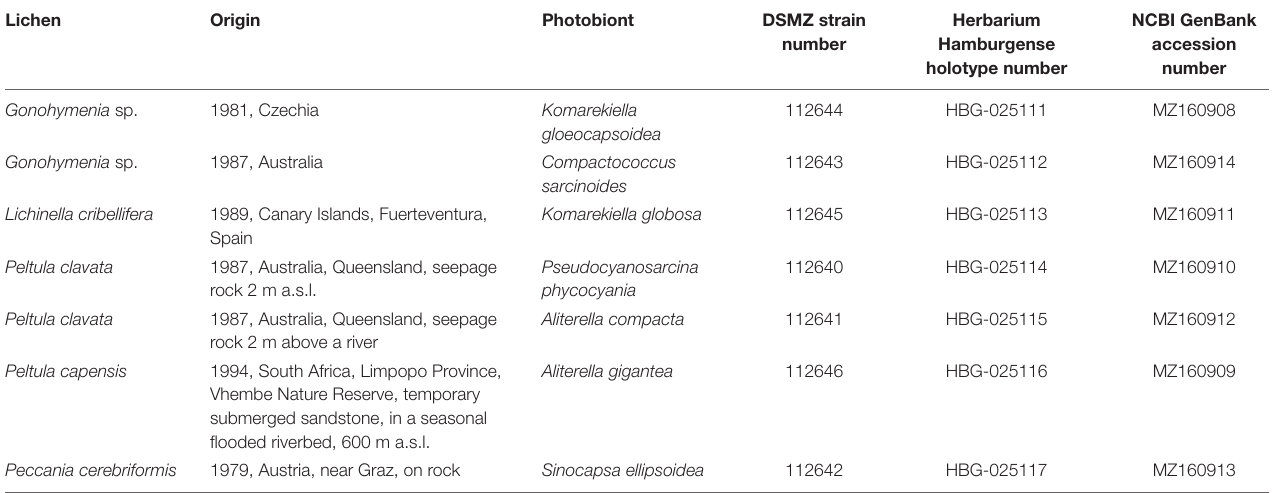
TABLE 1 | Overview of the new cyanobionts, the respective lichen and location of collection, and the final German Collection for Microorganisms and Cell Cultures (DSMZ) strain number as well as NCBI GenBank accession numbers and holotype deposition.